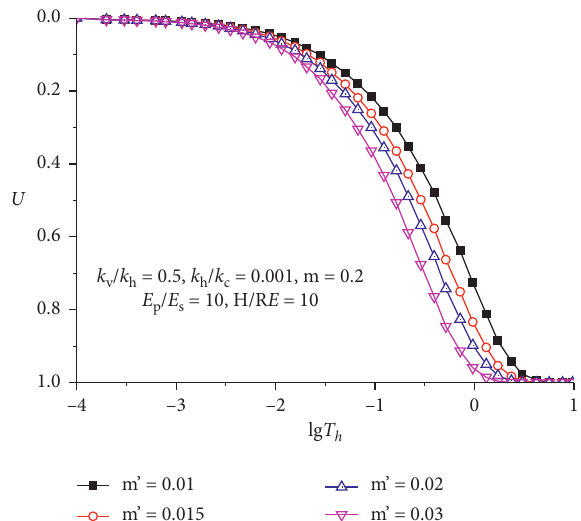
Figure 3: Influence of displacement ratio of drainage board on foundation consolidation rate.